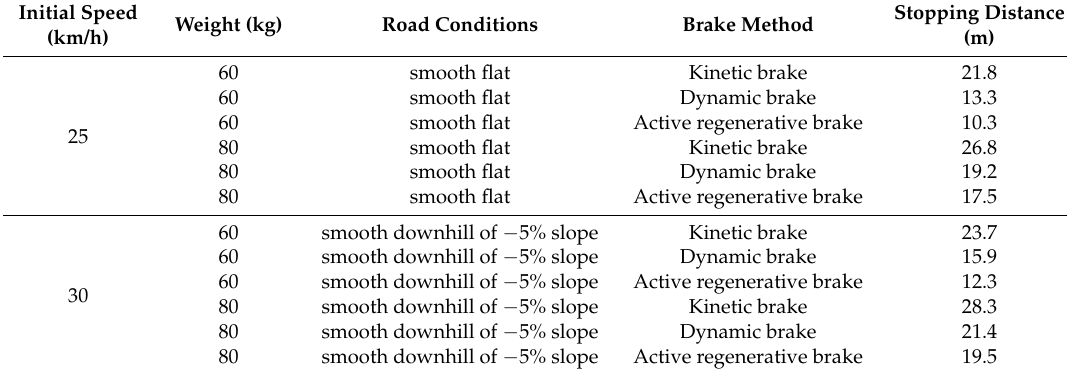
Table 3. Summary of HIL test